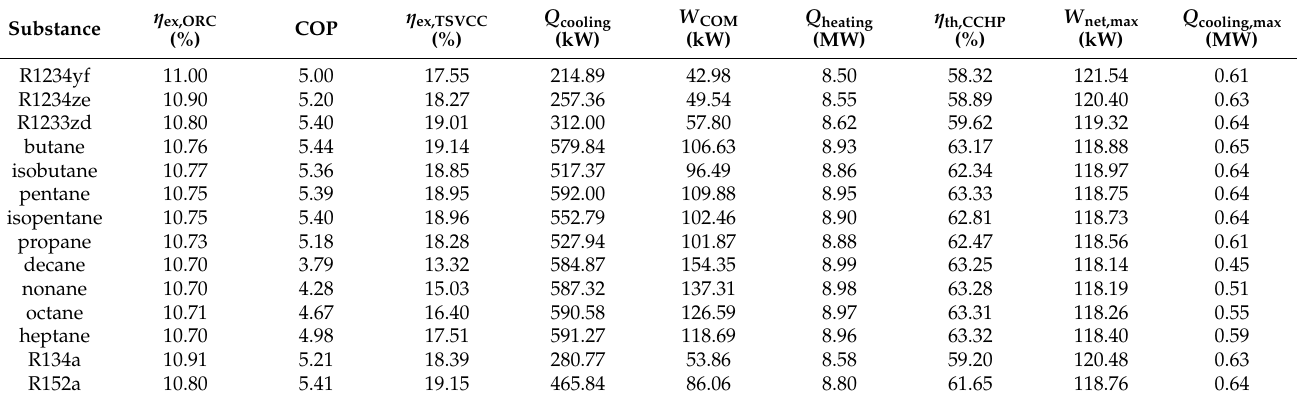
Table 4. Performance comparison of working fluids at temperature of geothermal fluid is 90 °C.